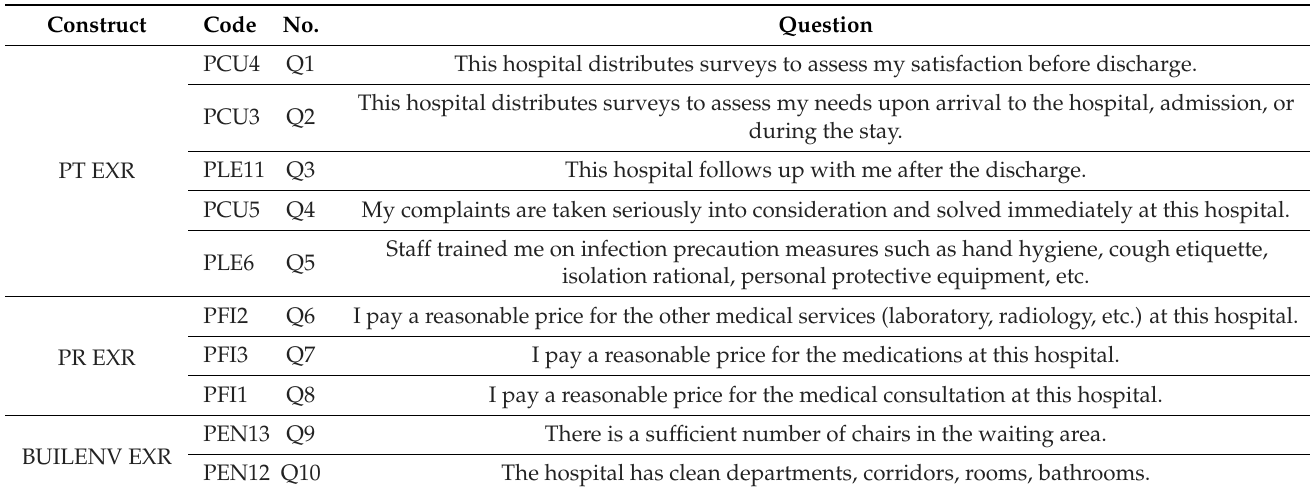
Table A3. Final resulted